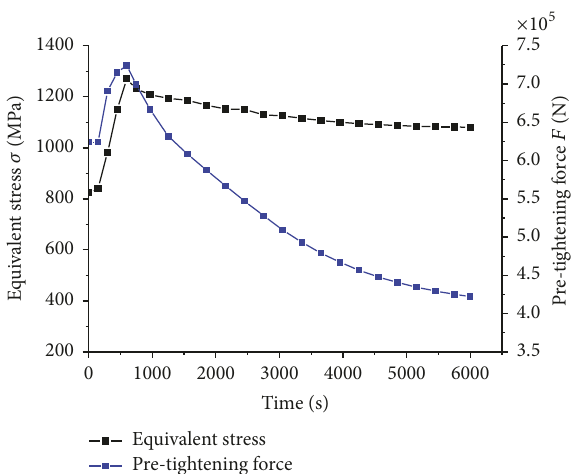
Figure 19: The variation of the maximum equivalent stress and pretightening force of the turbine tie rod.